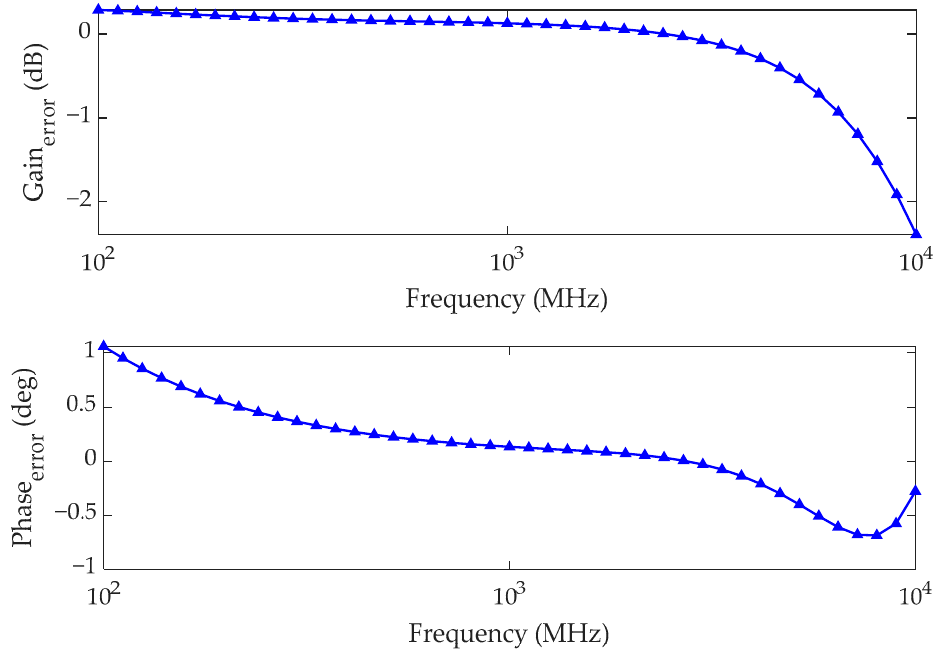
Figure 10. Gain and phase imbalance of proposed LNA.